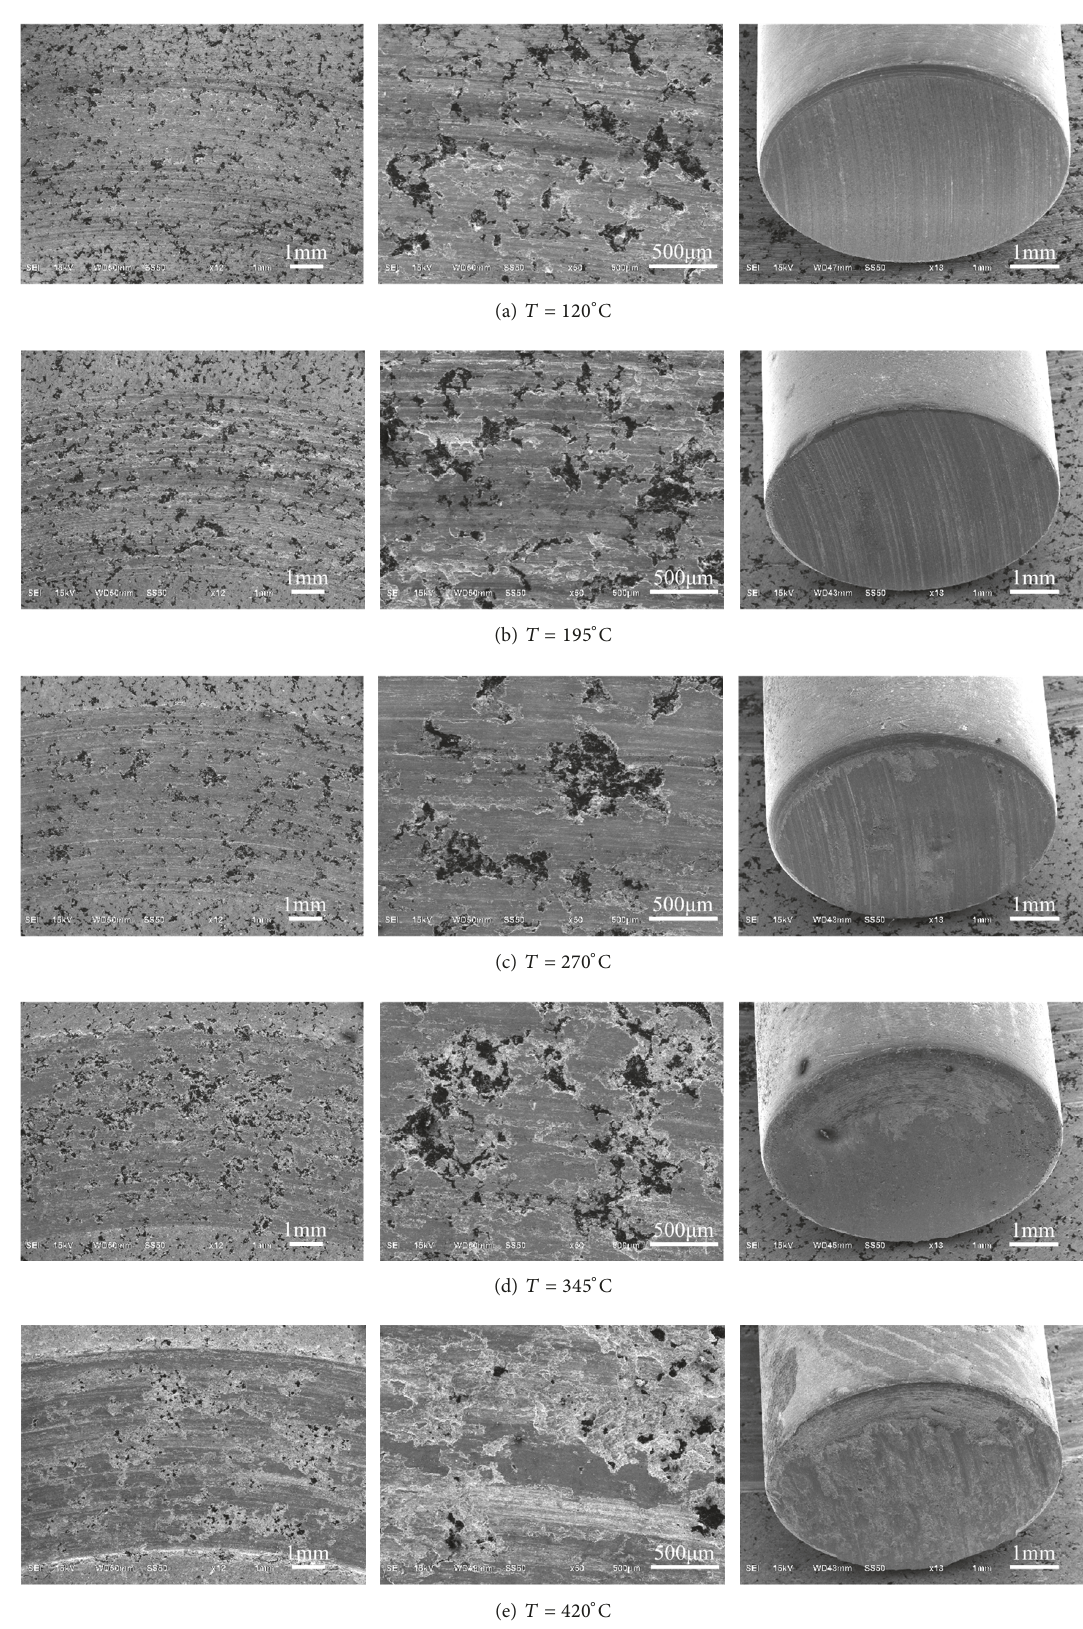
Figure 6: SEM micrographs of worn surfaces of Cu-based friction pairs after the